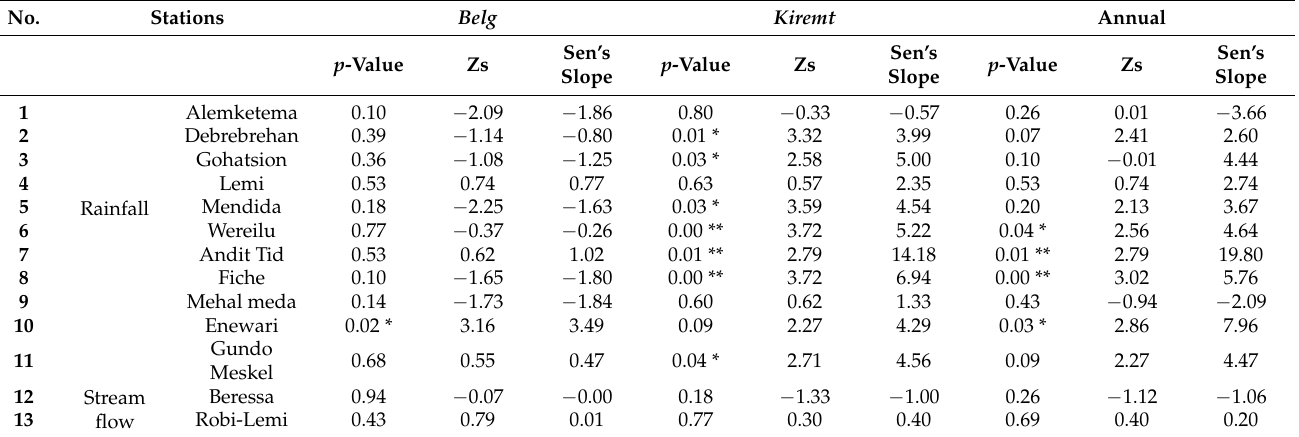
Table 3. Mann-Kendall trend analysis summary results of total annual and seasonal rainfall and stream